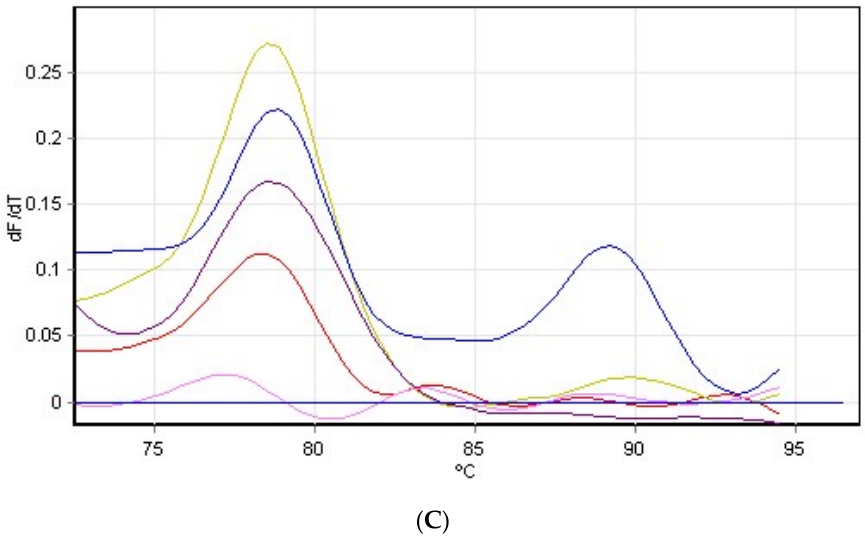
Figure 8. The melting curve of rbcL gene expression of 0 mM H 2 O 2 (untreated) plant ( A ), 15 mM H 2 O 2 -treated plant ( B ) and 20 mM H 2 O 2 -treated plant ( C ) by using RT-PCR reaction.